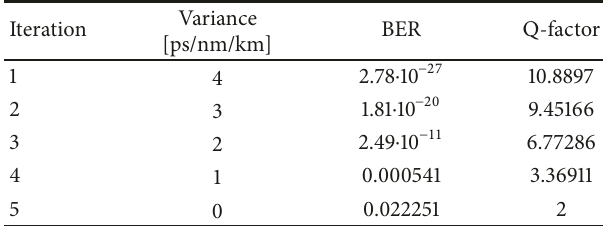
Table 1: Final results of BER simulations no.1 at 193,075 THz.